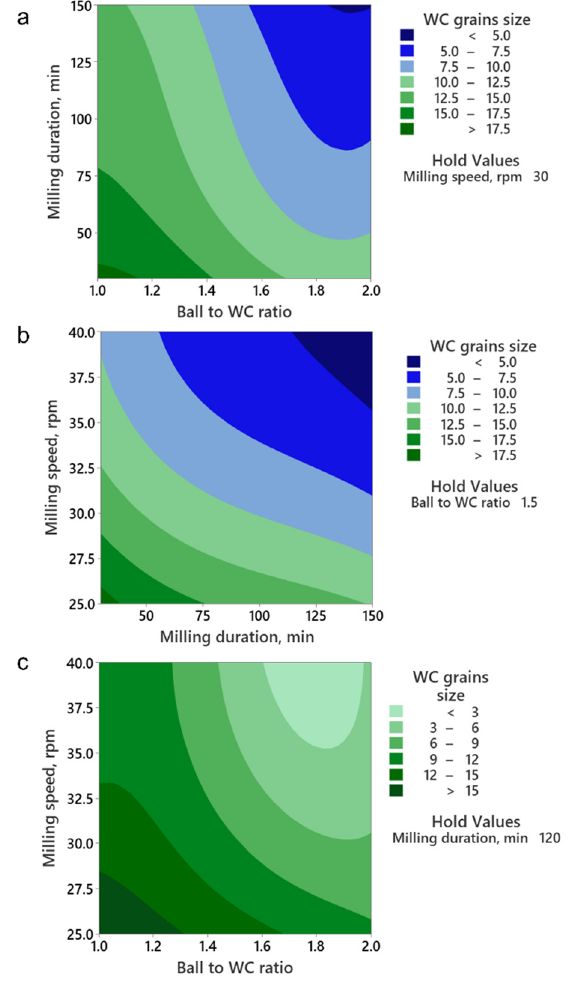
Figure 7. Two-parameter interaction plots for the WC grain sizes after ball milling. Interaction plots represent the combined influence of milling duration and ball-to-WC ratio ( a ), milling speed and milling duration ( b ), and milling speed and ball-to-WC ratio ( c ).